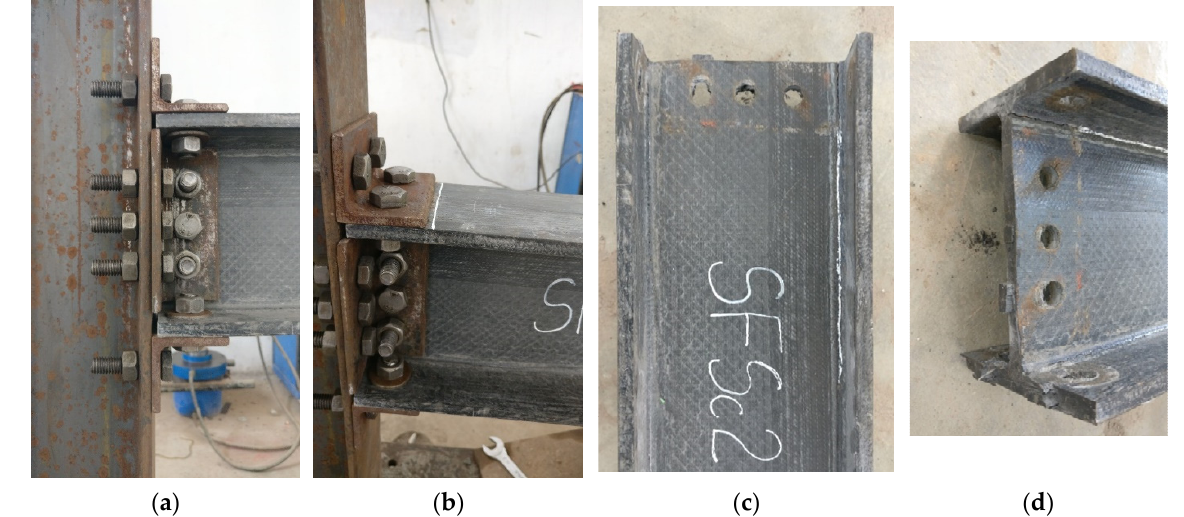
Figure 11. Shear-out failure in specimen SFSc2: ( a ) Undeformed joint; ( b ) Deformed joint; ( c ) Deformed beam top view; ( d ) Deformed beam close